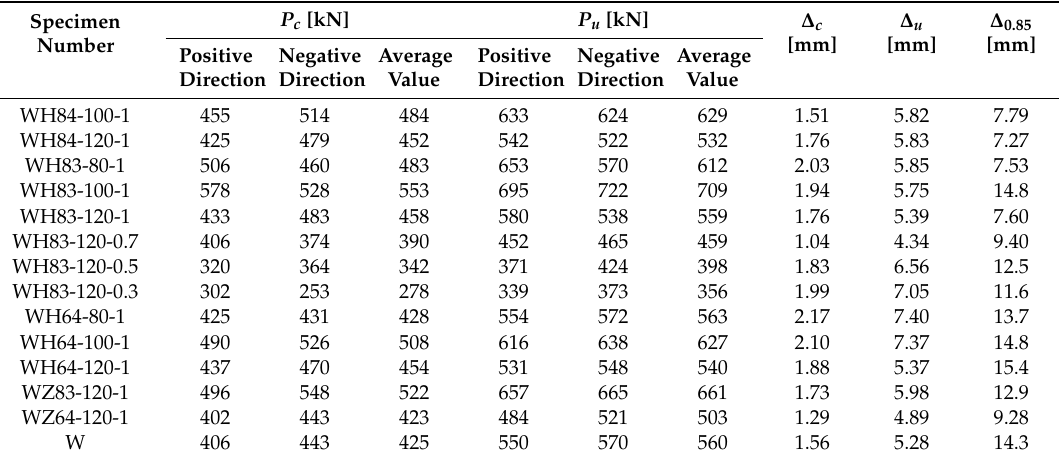
Table 3. Critical loads and corresponding